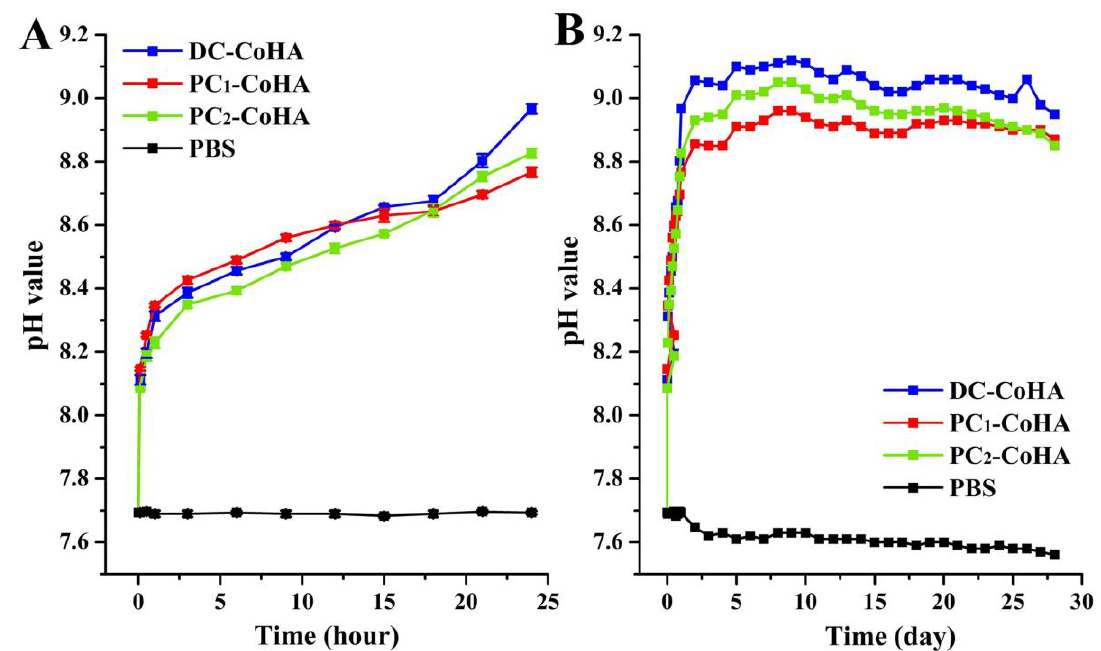
Figure 6. The pH values of different CoHA particles soaked in PBS solution at ( A ) 24 h and ( B ) 4 weeks.